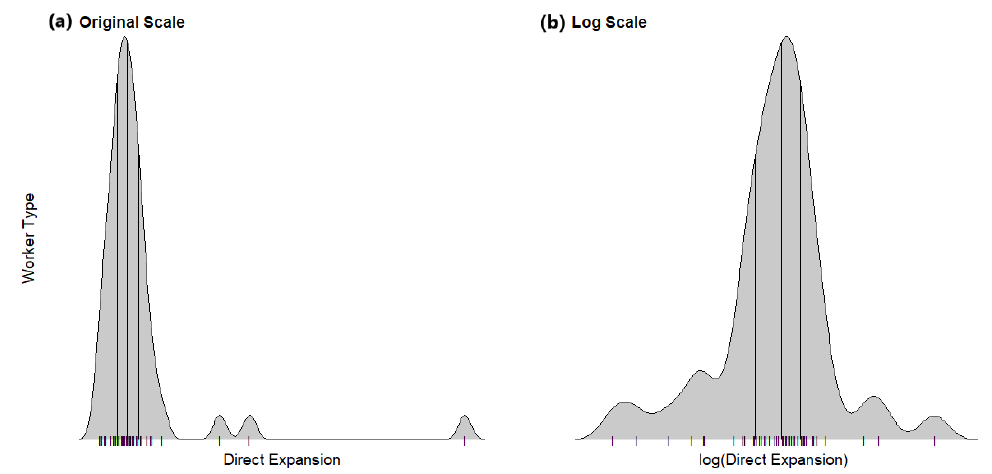
Figure 2. ( a ) Density plot of the original state-level survey estimates of number of workers, January 2020. ( b ) Density plot of the log-transformed survey estimates of number of